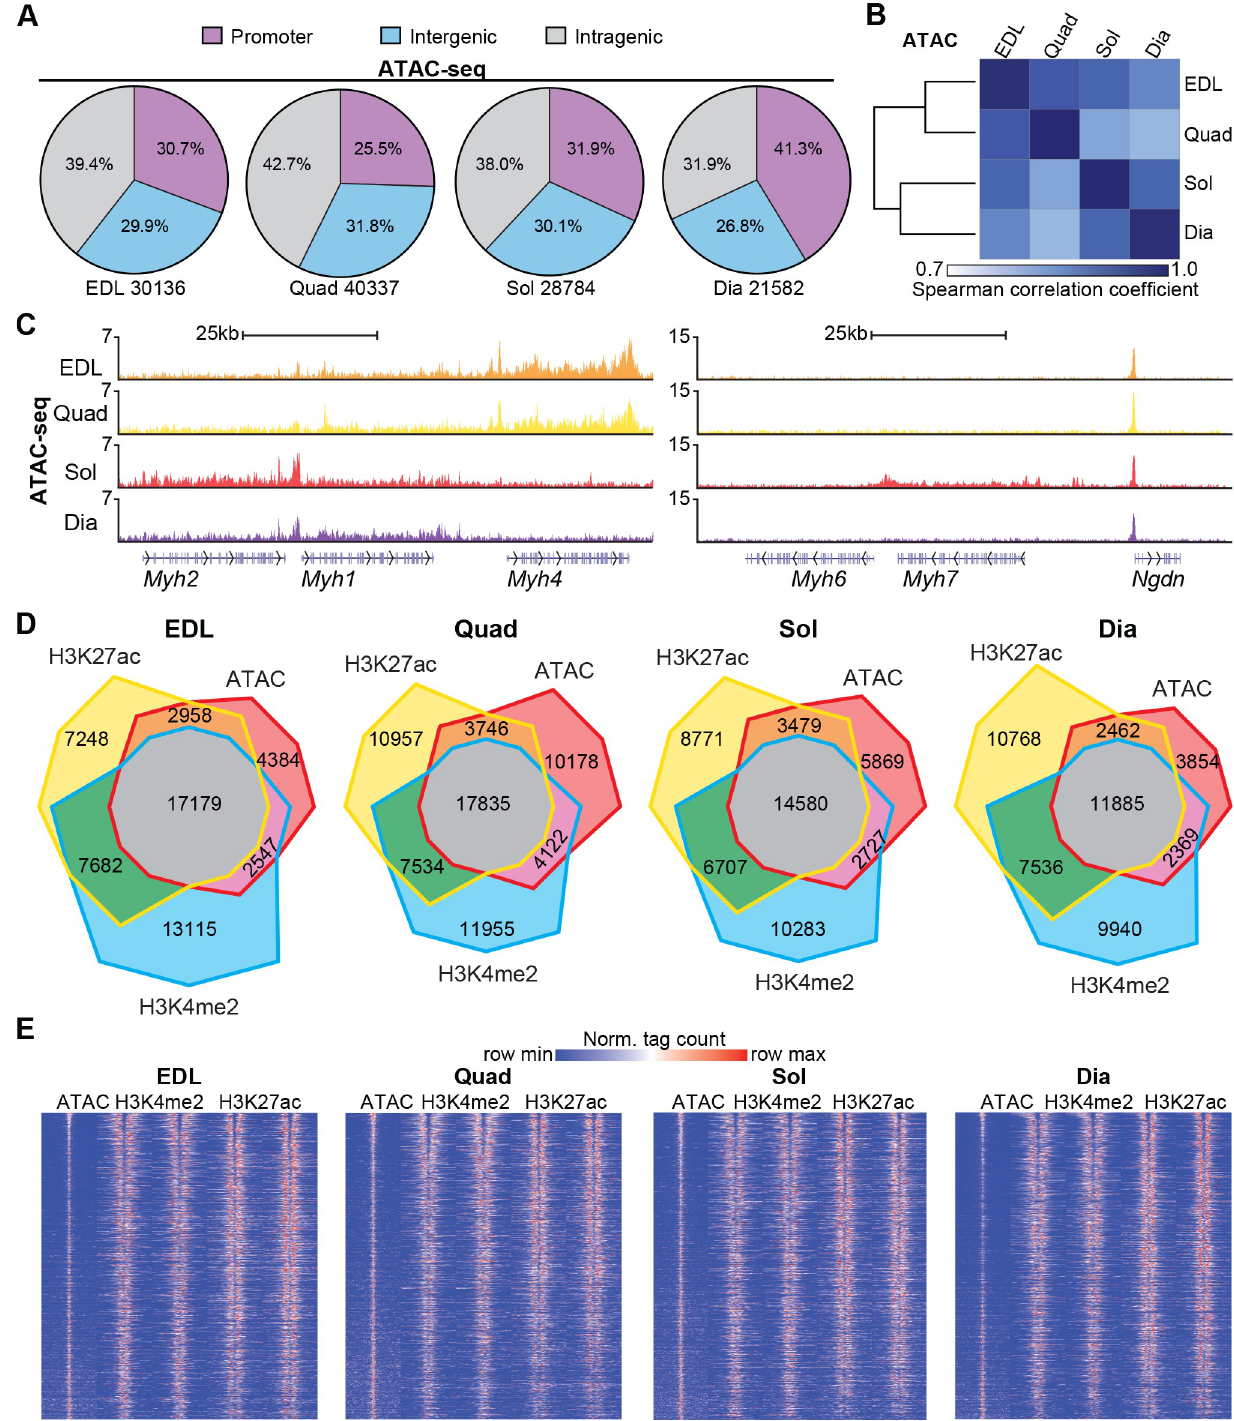
Fig 2. Patterns of open chromatin differ across muscle groups. (A) Genomic distributions of ATAC-seq peaks across EDL, Quad, Sol, and Dia in promoter, intragenic, and intergenic regions. (B) Similarity matrix for ATAC-seq profiles across muscle groups. Spearman rank correlation coefficient (r s ) is represented in color. (C) Representative UCSC browser tracks of ATAC-seq in EDL (orange), Quad (yellow), Sol (red), and Dia (purple) along Myh isoform genes. Myh6 is a cardiac isoform negative control gene, and Ngdn is a positive control gene invariant between different muscles. (D) Venn diagrams showing overlapping and unique regulatory regions (H3K4me2, H3K27ac, and ATAC-seq peaks) in EDL, Quad, Sol, and Dia. (E) Heatmap distribution of ATAC-seq, H3K4me2, and H3K27ac tags within 4 kb of all ATAC-seq peaks identified in EDL, Quad, Sol, and Dia; n = 1–2/group.